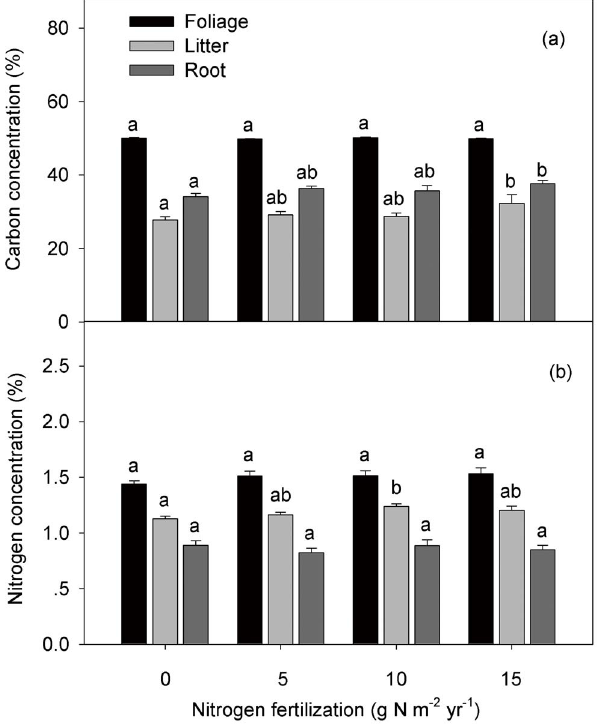
Figure 5. Carbon (a) and nitrogen (b) concentrations of foliage, litter, and fine roots in control and nitrogen (N) fertilized treatments. Significant differences among N treatments are indicated by different